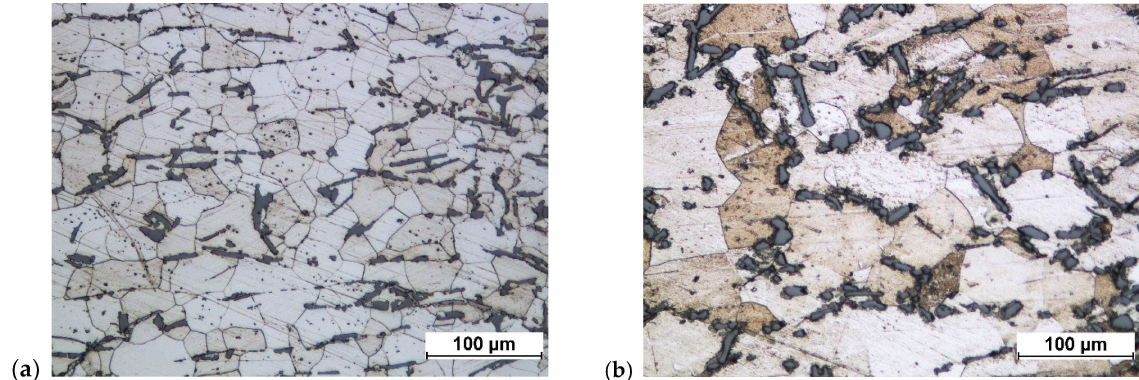
Figure 35. Connecting rod forging forged from a preform in accordance with variant 2: ( a ) on a crank press; ( b ) on a crank press and after heat treatment.